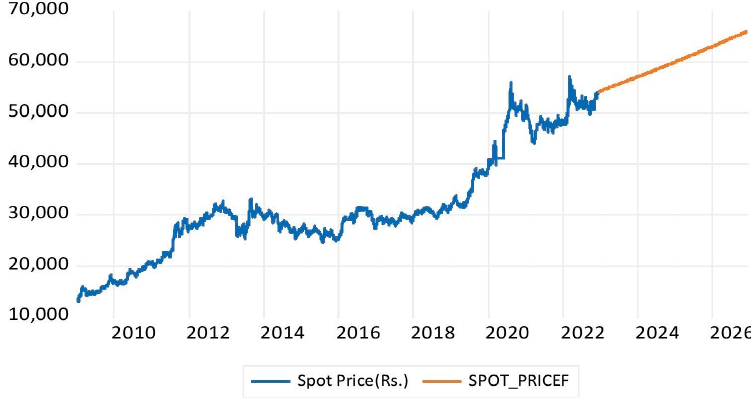
Figure 7. Gold Price Forecast for